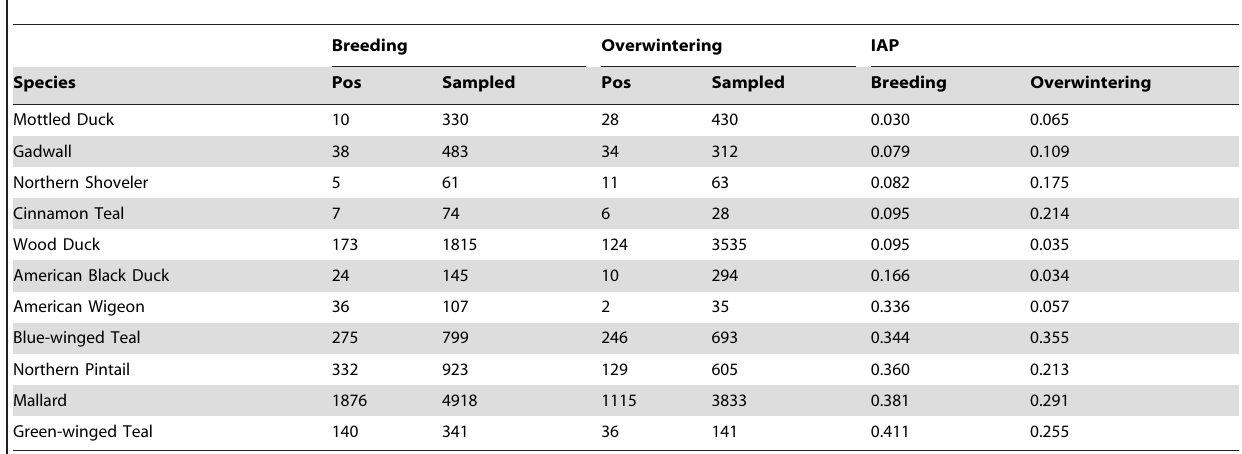
Table 1. Species, number of individuals testing positive for influenza A virus matrix gene by rRT-PCR (Pos), number of individuals tested for AIV (Sampled), and point estimate of interval apparent prevalence (IAP) in breeding and overwintering seasons for each species across all three years of data used in this